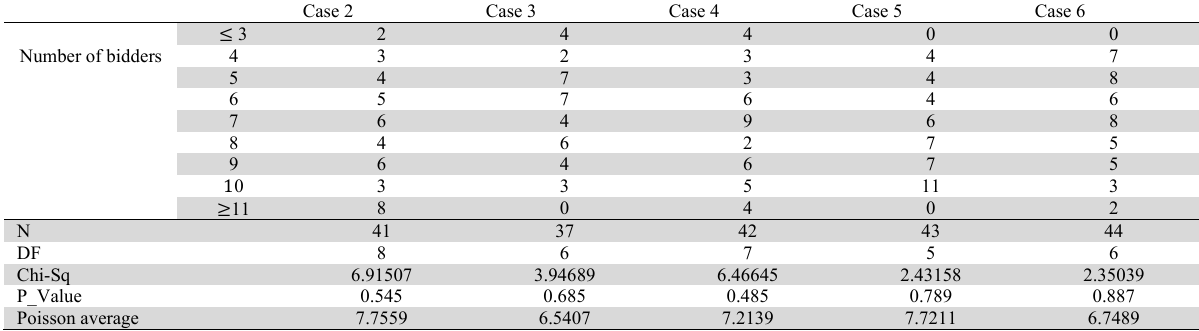
Outcome of the Chi-squared fitting test for the number of competitors.